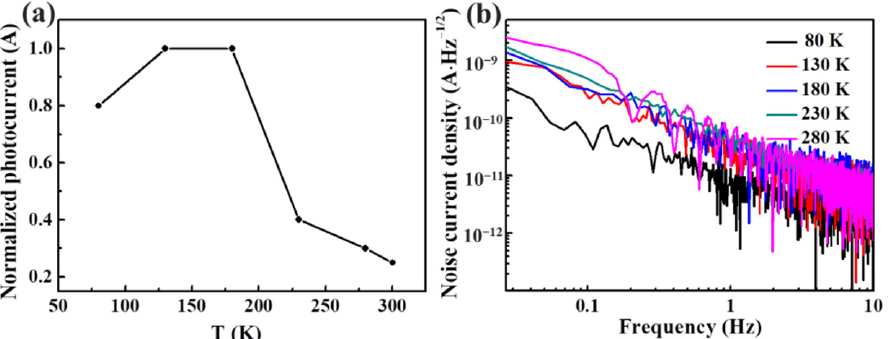
Figure 7. ( a ) The relationship between photocurrent and temperature of the device at 2000 nm; ( b ) spectra of noise current density with different operating temperature.